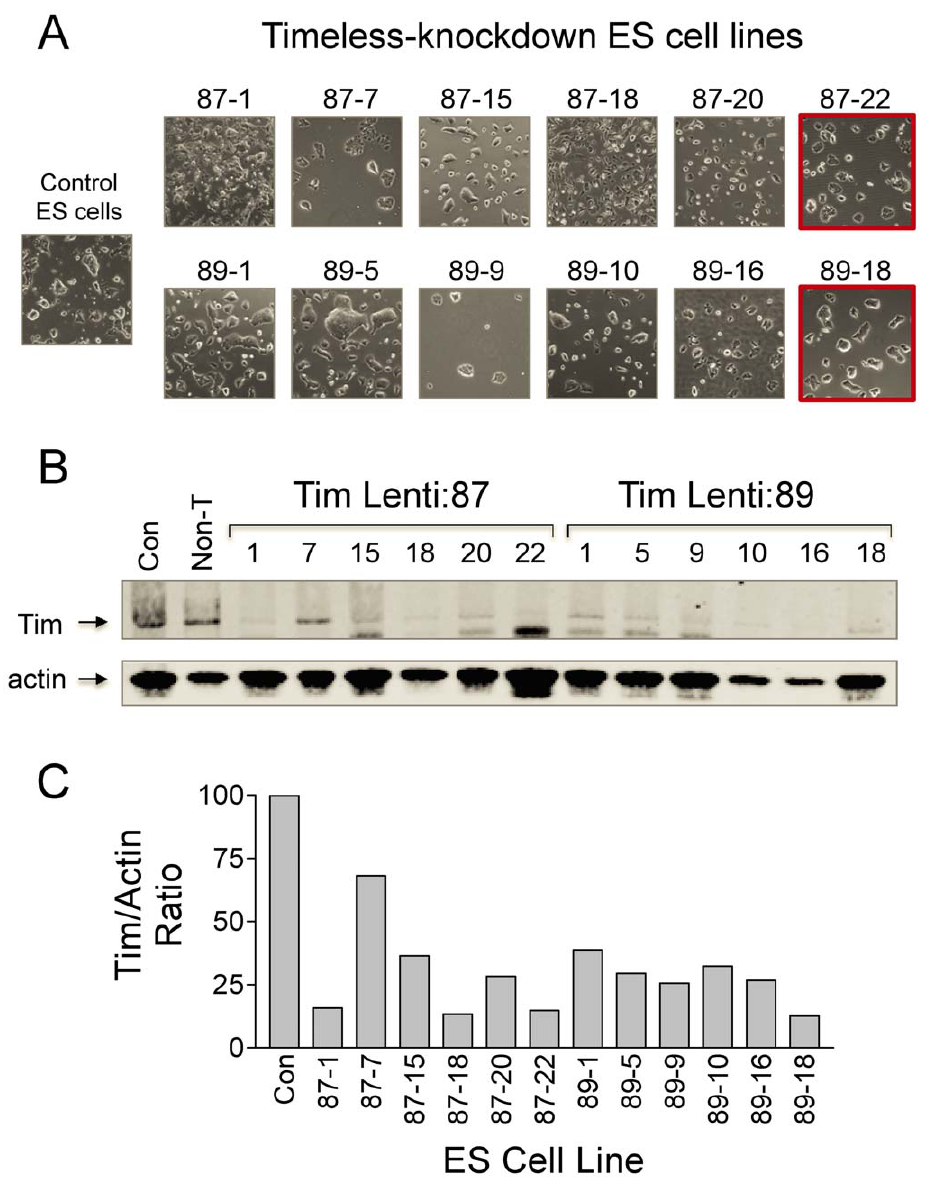
Figure 3. Generation of Tim knockdown ES cell lines. Endogenous Tim expression was suppressed in mES cells by transduction with lentiviral particles carrying shRNA sequences targeting independent regions of the Tim locus (Lenti:87 and Lenti:89). Following puromycin selection, 12 undifferentiated colonies were picked, expanded, and the levels of Tim protein expression determined by quantitative immunoblotting. A , Morphology of representative Tim-knockdown lines isolated from the Lenti:87 and Lenti:89 ES cell populations. Control ES cell colony morphology is also shown for comparison. B , The relative level of full-length Tim in lysates from each of the Tim knockdown lines shown in Part A was determined by quantitative immunoblotting (Tim; arrow). Immunoblots were also probed with an actin antibody as a loading control, and the relative levels of each protein were quantitated using the LI-COR Odyssey system and secondary antibodies conjugated to infrared fluorphores. C , Bargraph showing the Tim:actin protein ratios. Tim knockdown ES cell lines Lenti:87-22 and Lenti:89-18 were used in subsequent experiments based on unchanged ES cell colony morphology (Part A; red outline) and extent of Timeless knockdown.